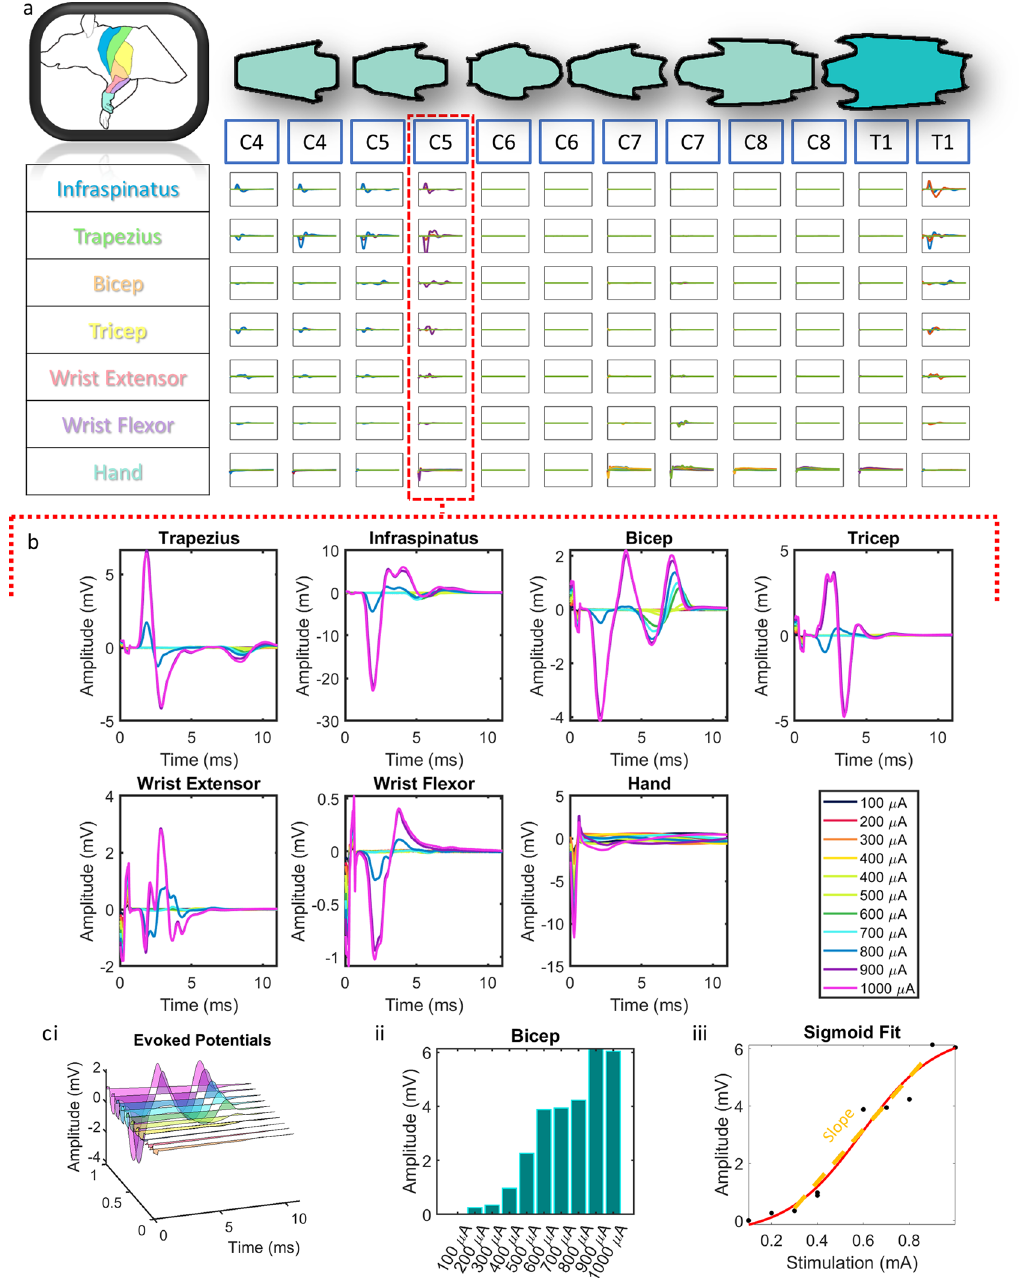
Figure 4. Point-to-point EMG. ( a ) Grid of evoked potentials from each muscle at each stimulated position along the spinal cord using point-to-point stimulation. Each square is an overlap of all of the traces at each stimulation amplitude. Each overlapped trace is the average of 20 repeats. *all graphs in grid are from 0 to 12 ms on the x axis and − 18 to 18 mV on the y axis. ( b ) An expanded view of ( a ) for a single stimulation point at the C5 level. ( c ) (i) For each muscle at each stimulation position, we took the recruitment curves at increasing stimulation intensities (ii) and extracted the evoked response amplitude. (iii) Then, we used a sigmoid fit function to extract the slope of the resulting dose response